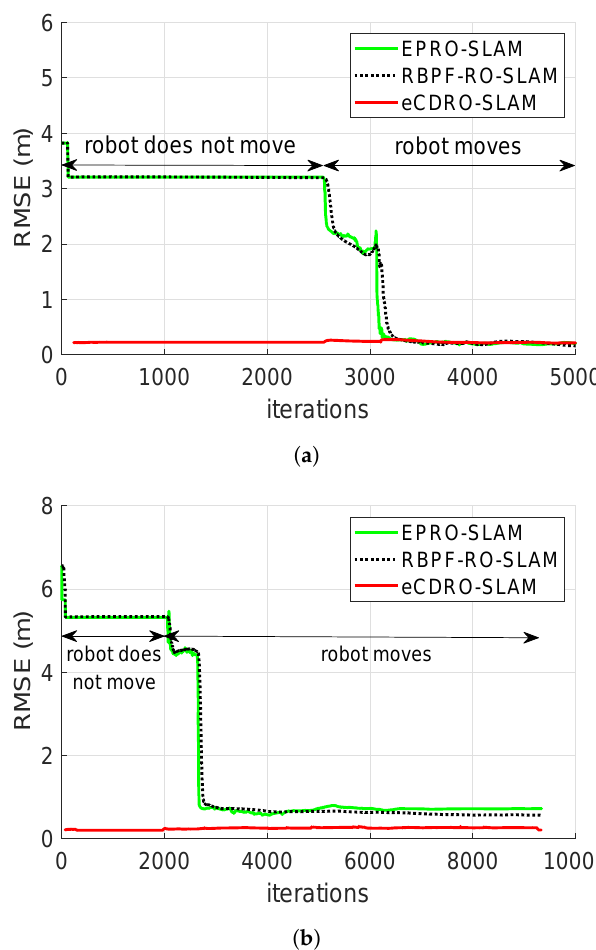
Figure 8. Map estimation performance obtained by the proposed eCDRO-SLAM and the conventional RO-SLAM algorithms [6,7] for ( a ) Experiment 1 and ( b ) Experiment